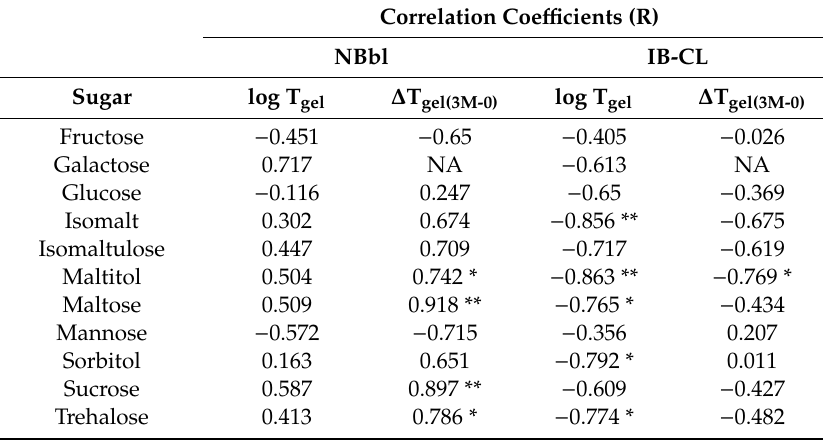
Table 6. Comparisons of correlation coe ffi cients (R) of slopes of log T gel vs. sweetener concentration (abbreviated log T gel in table) and ∆ T gel( i- 0) s in solutions of 3 M monosaccharide unit concentrations